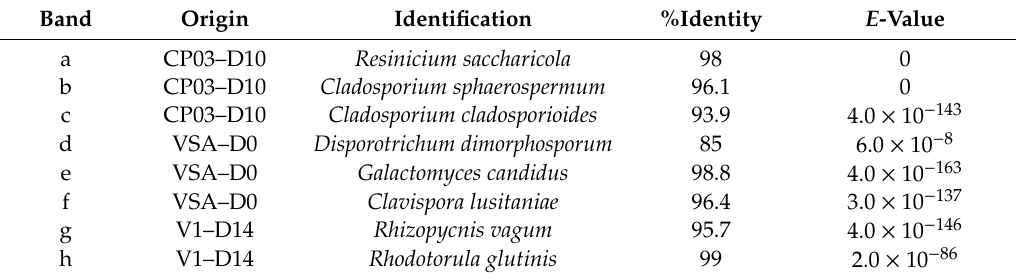
Table 5. Identification of fungal species from DNA extracted from DGGE